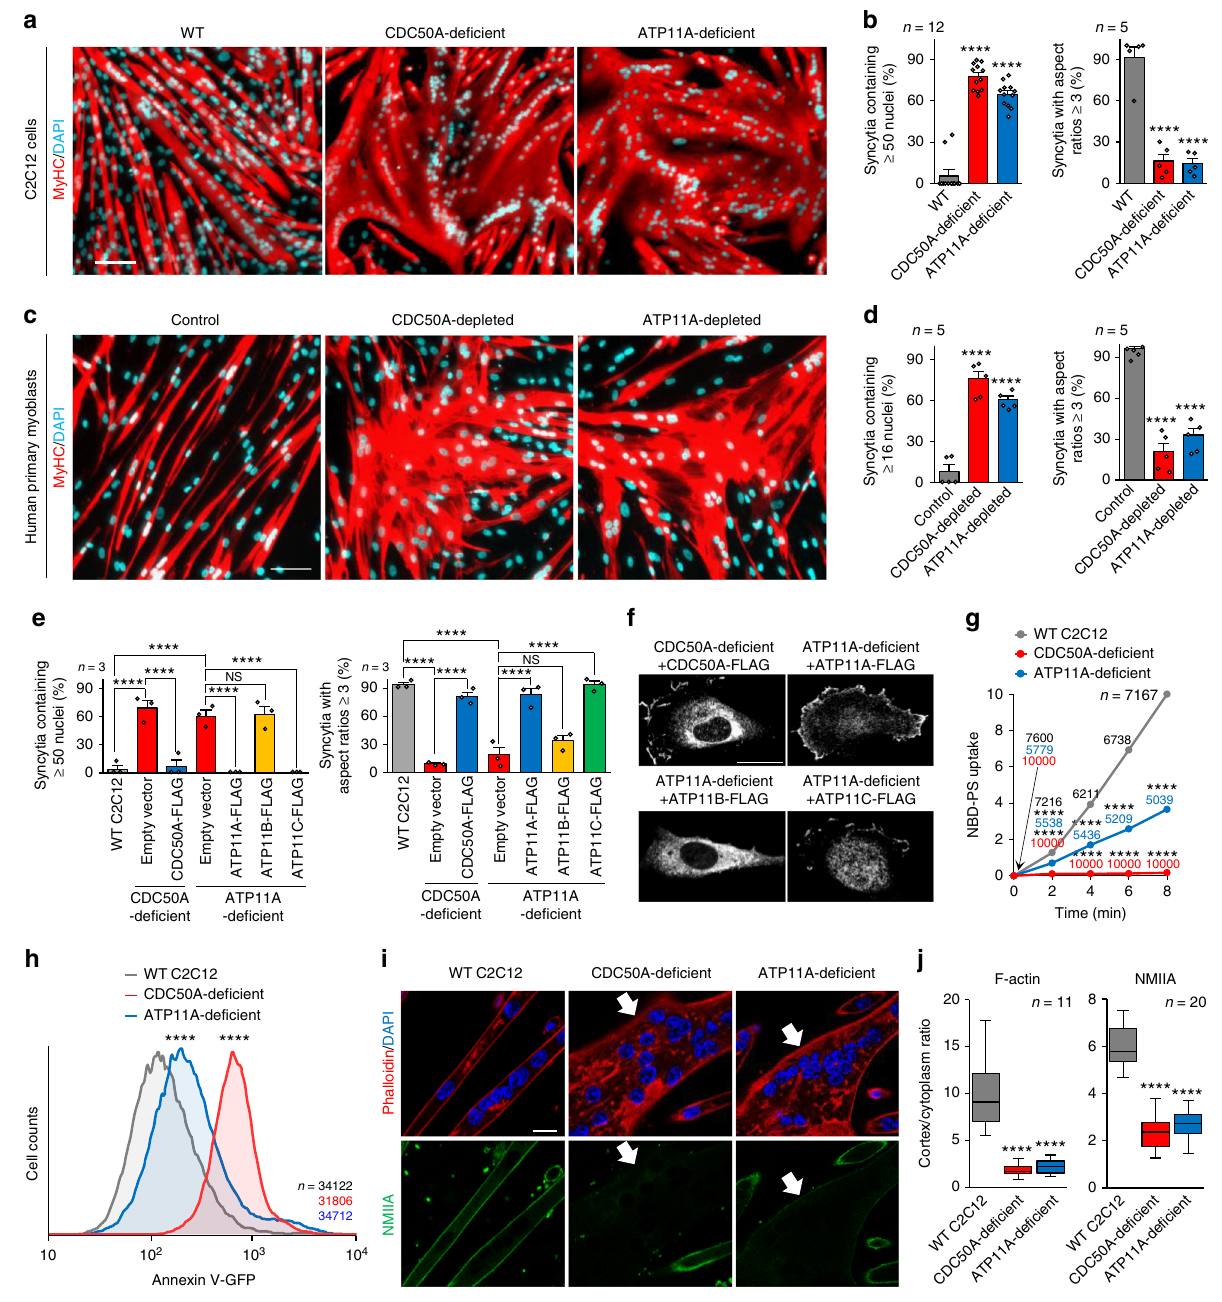
(Fig. 1h), fl uorescent spectroscopic analysis using the